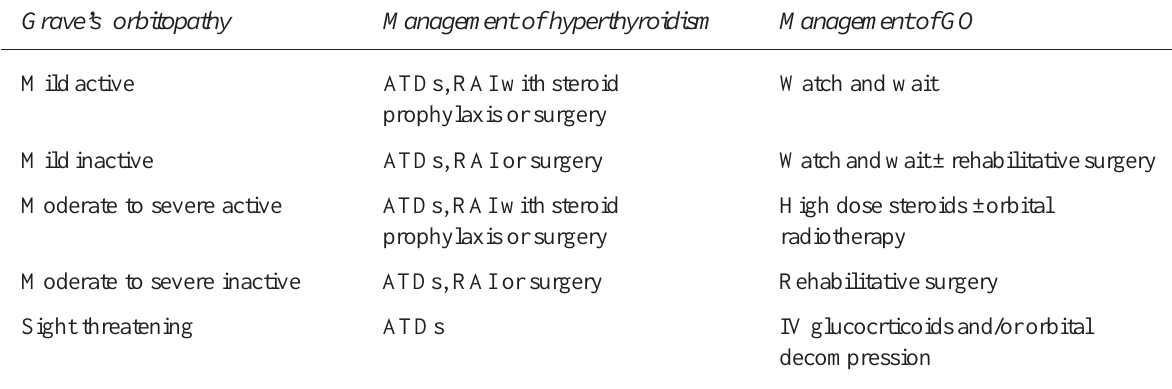
Table 2 . Management of hyperthyroidism and orbitopathy of Grave’s disease in different clinical settings Grave’s